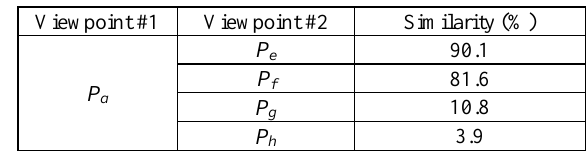
Table 1. Size Similarity between P a and plane of vewpoint #2